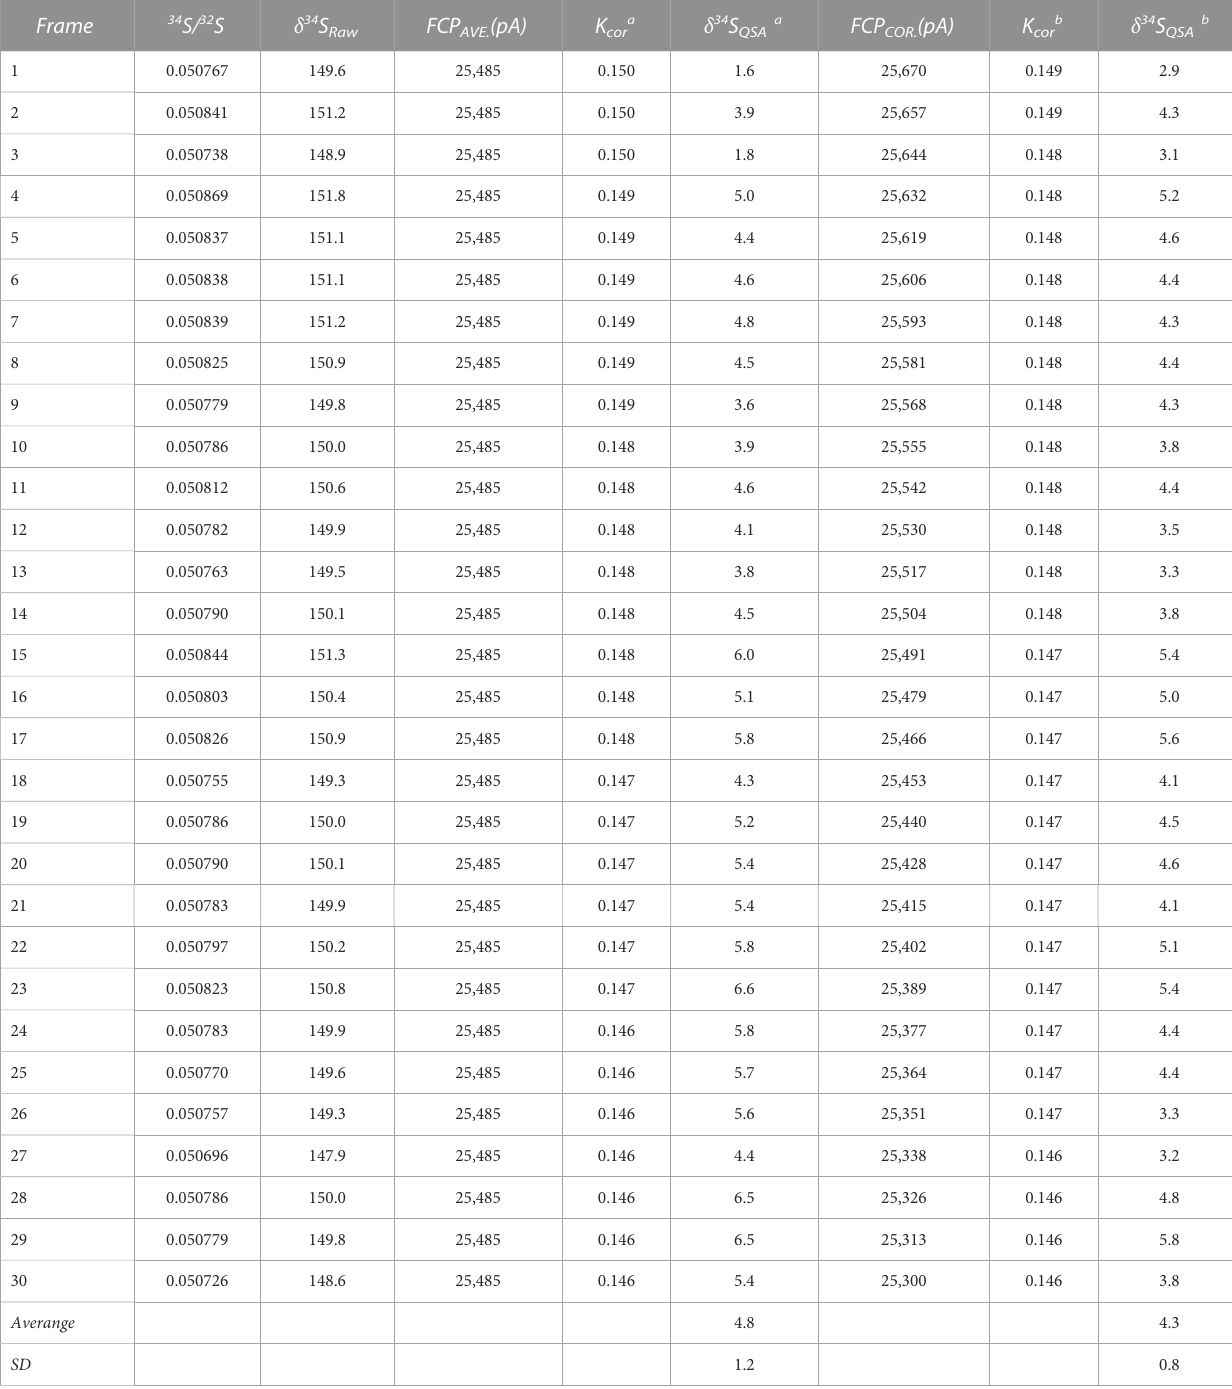
TABLE 2 The S isotopic results before and after FCP correction measured on the pyrite standard PY-SRZK.